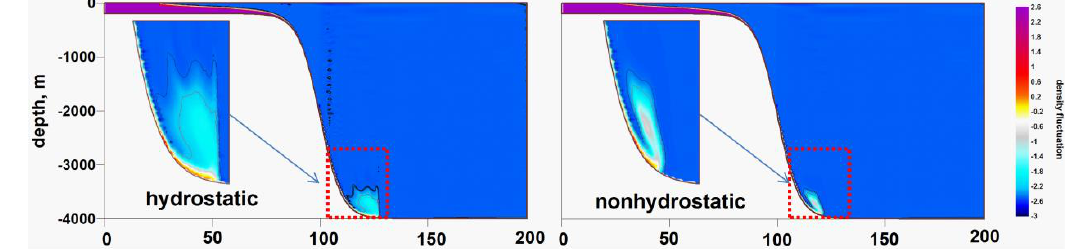
Figure A2. Density fluctuation distribution (kg/m 3 ) for the hydrostatic approach (left) and nonhydrostatic (right) at time = 10 h.